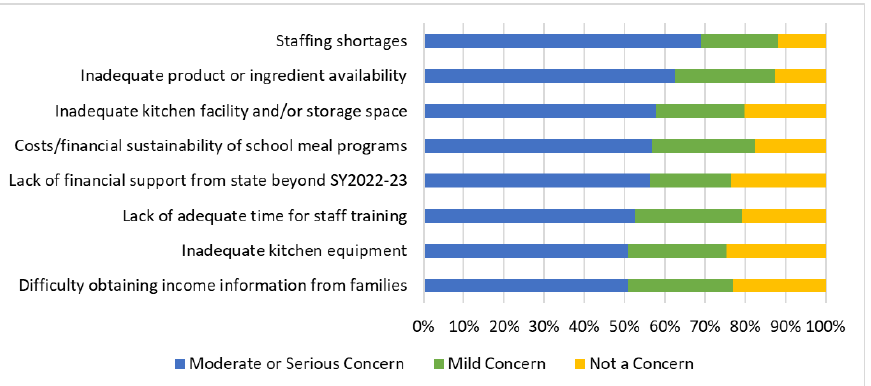
Figure 6. Greatest concerns about implementing universal school meals in the SY 2022 – 23 for Californian school food authorities ( n = 578 to 574 depending on missingness of responses). Stratified analyses showed that concerns about staffing shortages, inadequate kitchen facilities and/or storage space, and inadequate kitchen equipment, were higher among SFAs with 40% or fewer students eligible for FRPMs than in those with more than 40% of students eligible for FRPMs ( p ≤ 0.05) (Table 6). Concerns about implementing USM in the SY 2022 – 23 did not differ by urbanicity ( p > 0.05). Large SFAs were more concerned about costs/financial sustainability of school meal programs and lack of financial support from the state for USM beyond the SY 2022 – 23 than small SFAs ( p < 0.02). Large and me- dium SFAs were more concerned about staffing shortages, inadequate product or ingre- dient availability, inadequate kitchen facilities and/or storage space, lack of adequate time for staff training, and inadequate kitchen equipment, compared with small SFAs ( p- value for pairwise comparisons < 0.025). Table 6. Greatest concerns about implementing California’s universal school meals in SY2022 – 23 by select characteristics of school food authorities ( n = 581) 1 .